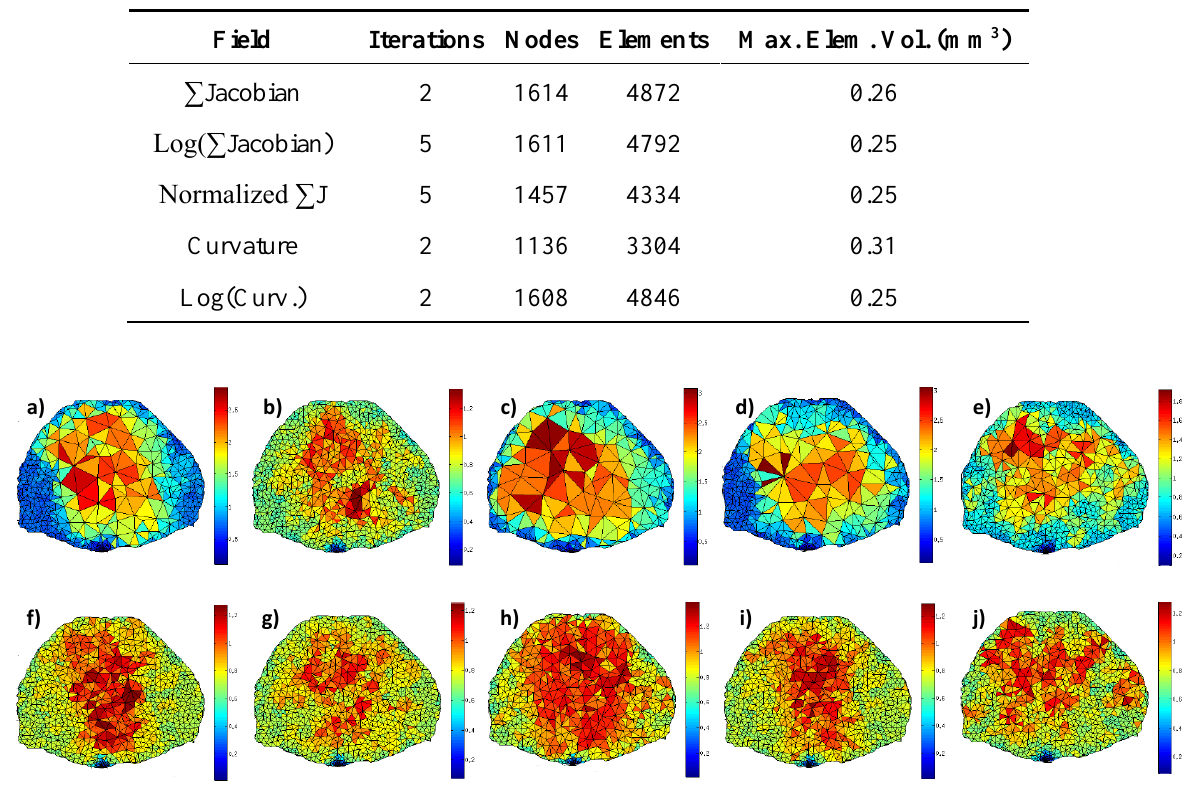
Figure 6. Upper row: mesh at convergence ( a ) ∑ 𝐽𝑎𝑐𝑜𝑏𝑖𝑎𝑛 , ( b ) 𝑙𝑜𝑔(∑ 𝐽𝑎𝑐𝑜𝑏𝑖𝑎𝑛) , ( c ) 𝑛𝑜𝑟𝑚𝑎𝑙𝑖𝑧𝑒𝑑 ∑ 𝐽 ; ( d ) 𝑢 and ( e ) 𝐿𝑜𝑔(𝑢) ; lower row: mesh at 0.25 mm 3 stopping criterion for the respective corresponding input